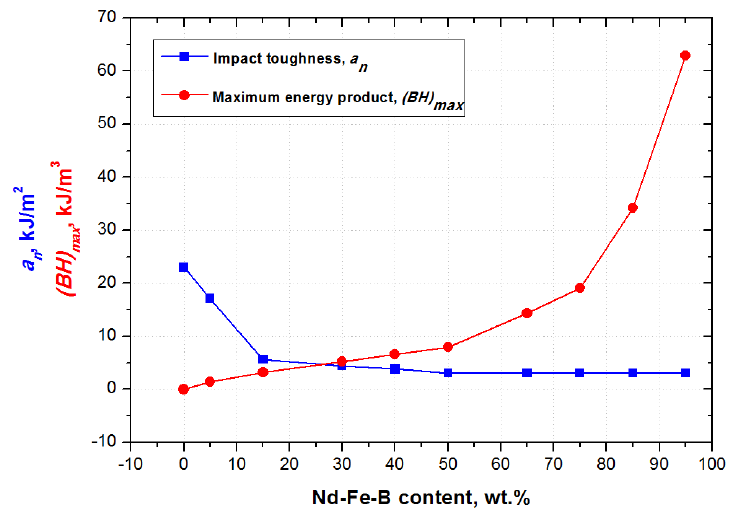
Figure 10. Impact toughness and maximum energy product versus Nd-Fe-B content. Values for impact toughness a n were taken directly from the impact tester and intro- duced as a function of the Nd-Fe-B weight fraction (Figure 10). The impact toughness was found to decrease from 9.3 to 1 kJ/m 2 , as the Nd-Fe-B magnetic particle content was increased from 10 to 95 wt.%. The pure epoxy resin also showed that the highest attainable impact toughness is 23 kJ/m 2 . Comparing the two curves presented in Figure 10, it is obvious that a contrasting trend is achieved, when varying Nd-Fe-B content, between impact toughness and maximum energy produced.